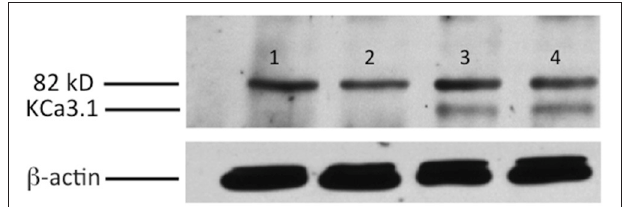
FIGURE 1 | Membrane location of KCa3.1-BLAP stably expressed in FRT cells. The sidedness experiments confirm the expression pattern of KCa3.1 on the basolateral membrane of FRT cells. FRT cells with KCa3.1-BLAP were grown on Transwell TM filter inserts to form a monolayer, and then labeled with streptavidin in the apical, basolateral, or both sides of the filter insert. Bands were only observed in the samples that were labeled basolaterally near the 82 kD mark. Lane 1: untransfected FRT, Lane 2: KCa3.1-BLAP + Apical streptavidin labeling, Lane 3: KCa3.1 + Basolateral streptavidin labeling, Lane